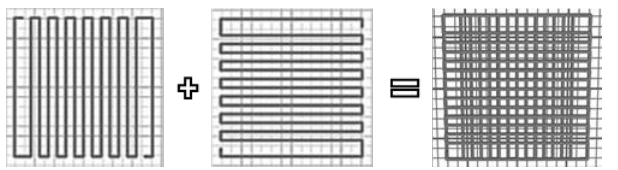
Figure 13. Top-view of the schematic printed layers and the resulting grid. Strand distance 1.8 mm, strand height 0.4 mm in a printing angle change of 90° per layer.